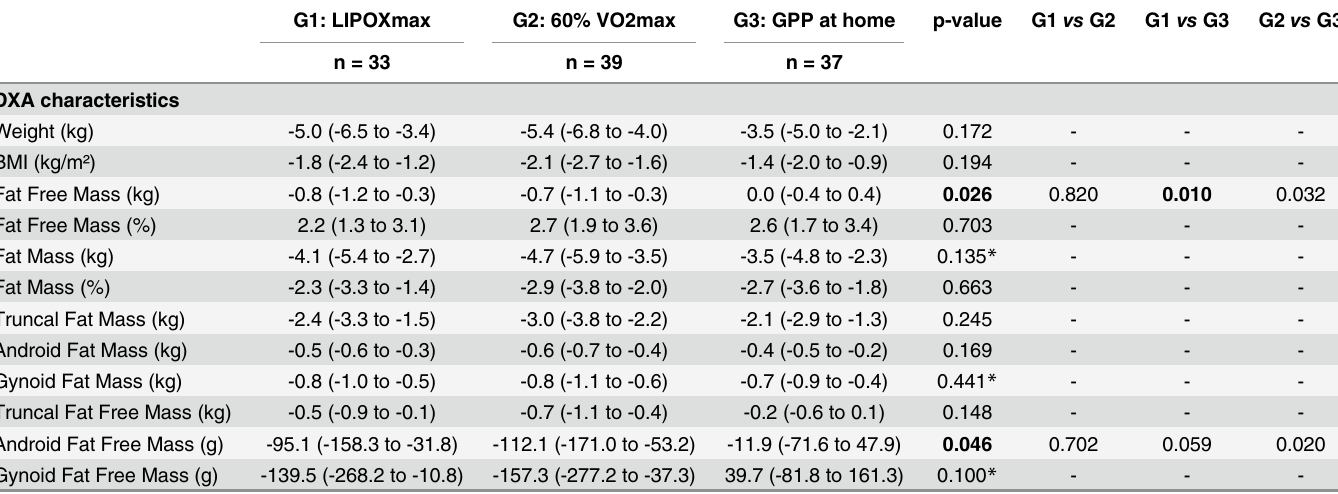
Table 3. Five-month changes in anthropometric and body composition in LIPOXmax-Réunion randomized controlled trial